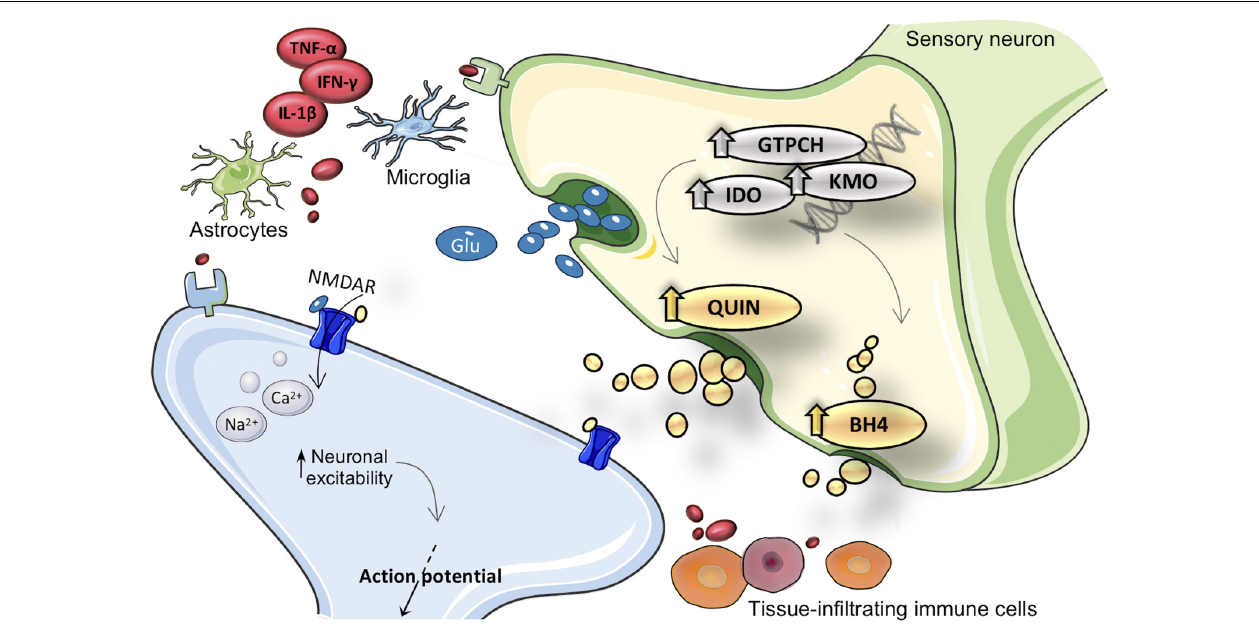
FIGURE 1 | Merger of kynurenine (KYN) and tetrahydrobiopterin (BH4) pathways into inflammation cascade involved in pain hypersensitivity. After inflammatory activation, expression and activity from GTPCH (guanosine triphosphate cyclohydrolase I), IDO1 (indoleamine 2,3-dioxygenase), and KMO (kynurenine 3-monooxygenase) enzymes are enhanced in brain and immune cells. Inflammatory inducible KYN/BH4 pathways upregulation is characterized by increased nociceptive compounds, such as QUIN (quinolinic acid) and BH4. As a consequence, neurons undergo profound changes in activity, which eventually result in exacerbated pain sensations. The neuroactive compound QUIN is NMDAR (N-methyl-d-aspartate receptor) agonist it is proposed to exacerbate hypersensitivity throughout modulation of this receptor. The exact molecular mechanism by which BH4 induces pronociceptive effects is not fully elucidated. TNF- α , tumor necrosis factor alpha; IL-1 β , interleukin-1beta; IFN- γ , interferon gamma; Glu,